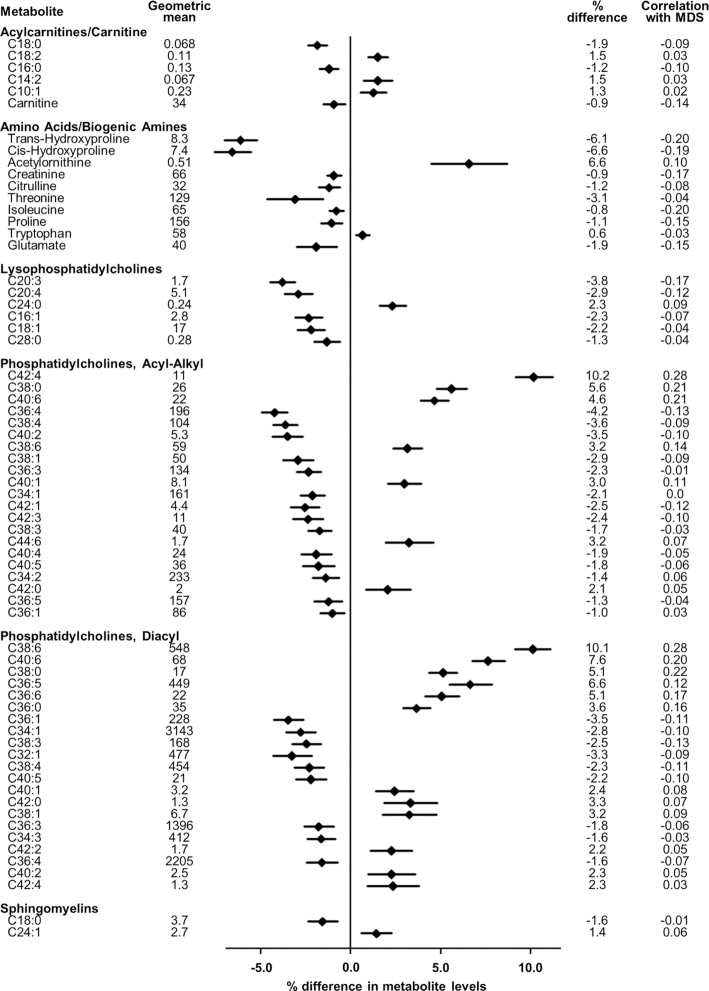
Association of the Mediterranean diet with metabolite concentrations: the Fenland Study (n = 10,806, 2005–2015). Percentage difference in metabolite concentrations based on linear regression fitted to data from 10,806 participants (recruited in 2005–2015) for an association of the MDS (per SD) with each of the log-transformed metabolites. Geometric means of metabolites measured in micromoles per liter for the amino acids and biogenic amines, and relative concentrations for the other metabolites. For acylcarnitines, phospholipids, and sphingolipids, numbers of carbons and double bonds of acyl moieties are presented. Correlation represents Spearman's ρ with the MDS. MDS, Mediterranean diet score.